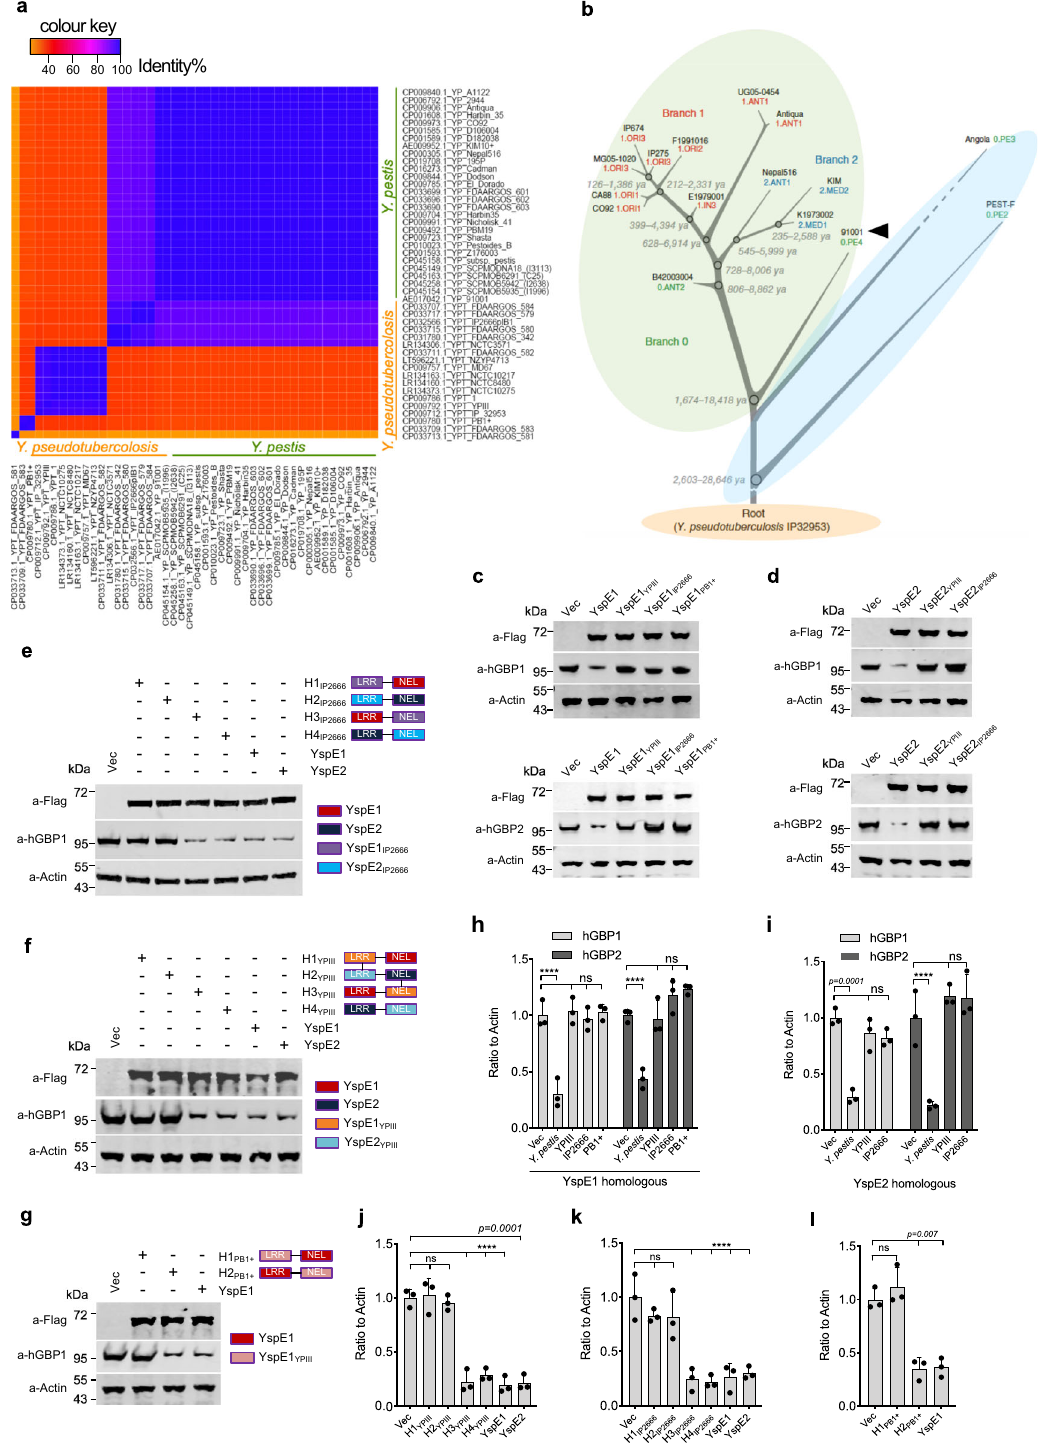
between YspE1/YspE2 and hGBP1 were 3.7×10 − 7 M and 1.5×10 − 6 M, respectively, and the LRR domain of YspE1/YspE2 showed the similar K D to their full-length counterparts, all of which are lower than that of Shigella IpaH9.8 (2.9×10 − 8 M). K D between YP_3417 and hGBP1 was the lowest one in all the tested molecules mainly due to a relatively higher dissociation rate constant (Fig. 5o). There are eleven GBPs known in mouse, encoded on the chro- mosome 3 (mGBP 1, 2, 3, 5 and 7) and 5 (mGBP4, 6, 8, 9, 10 and 11), respectively.We further determined how the stability of mGBPs